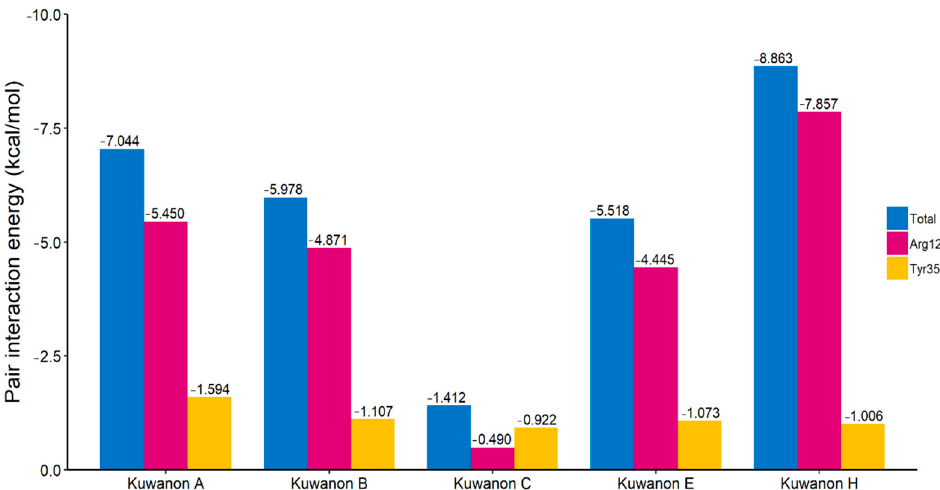
Figure 3. The pair interaction energies between the kuwanon derivatives and the two amino acids in the gate of the COX active site. Both Arg120 and Tyr355 play a major role at the gate of the COX active site.